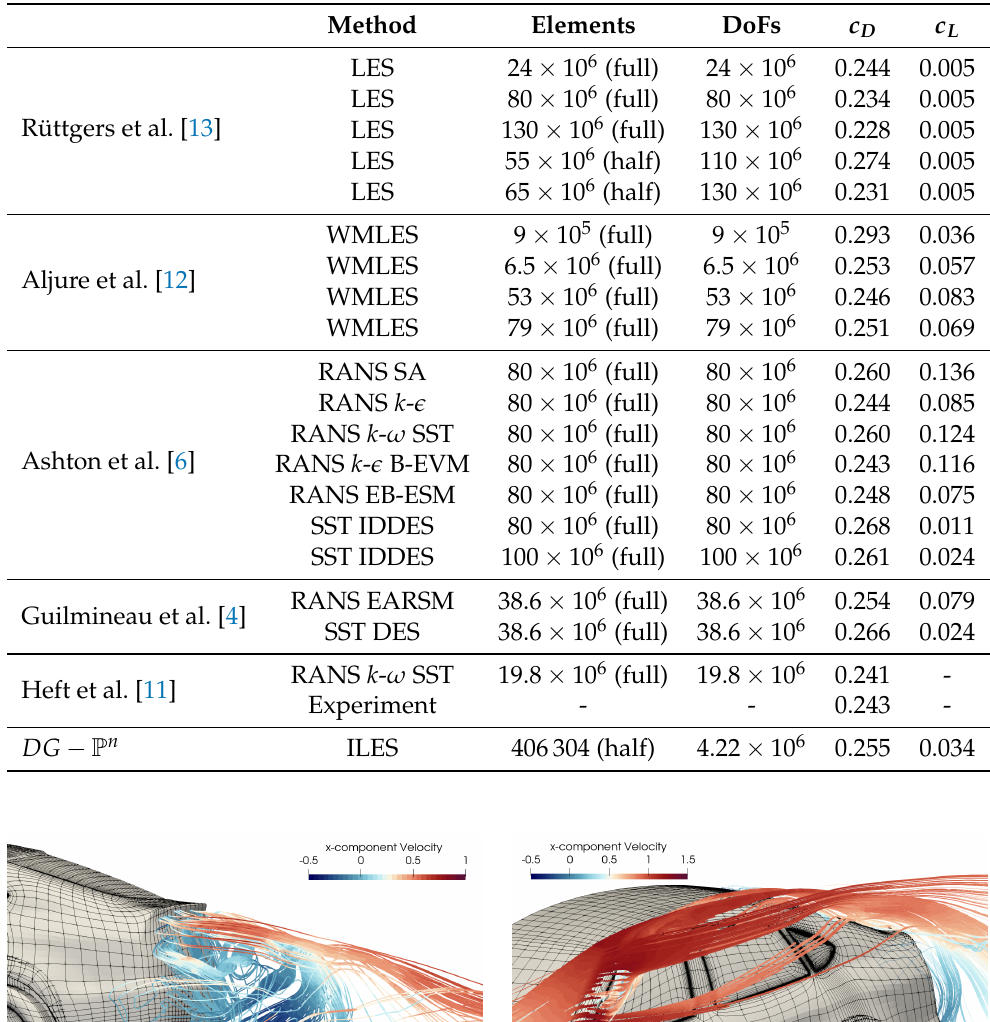
Table 2. DrivAer model—Drag, c D , and downforce, c L , coefficients in comparison with other reference numerical results and experimental data. DoFs are the degrees of freedom, i.e., the unknown solutions. All the reference solvers are based on cell-centered finite-volume methods, i.e., the DOFs are equal to the mesh elements. DoFs of the simulations for half model are reported projected to the full model simulation in order to have an easy comparison.